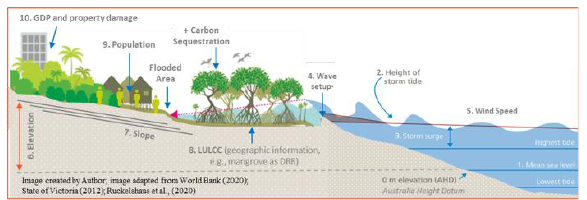
Figure 9. Coastal flood pathways and key